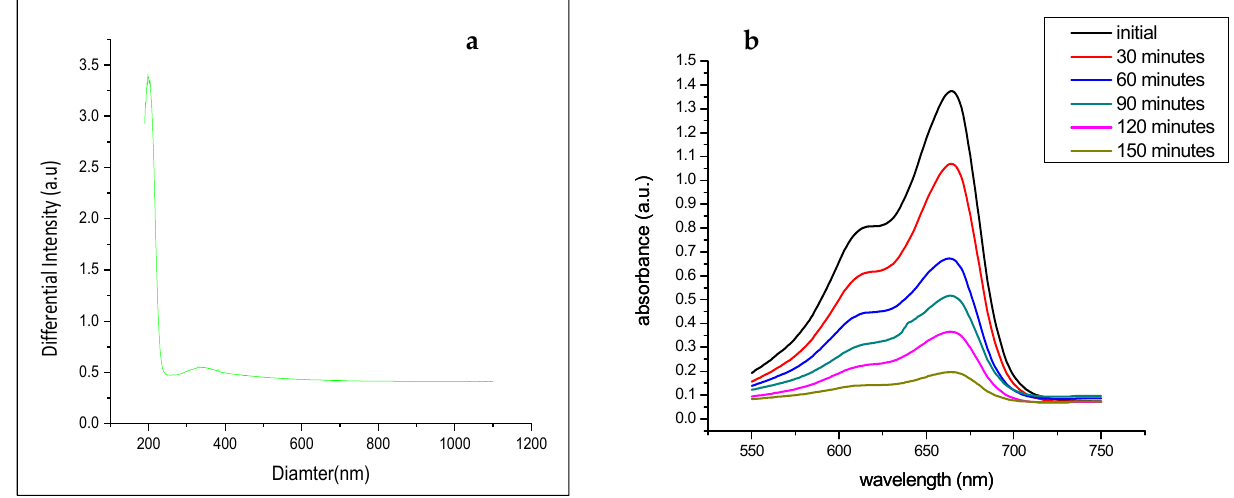
Figure 5. ( a ) UV/Vis spectrum of Cerium nanocomposites (CeO 2 -CuO) and ( b ) time-dependent optical absorbance spectra of methylene blue (MB) showing the gradual decrease in concentration with time of CeO 2 -CuO used as catalyst.